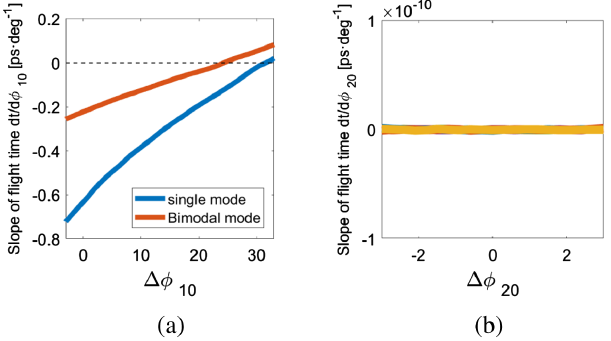
FIG. 7. Slope of flight time as function of injection phases at the gun exit. (a) The slope of ight time as function of fundamental mode injection phase dt=d ϕ 10 . △ ϕ ∘ 10 ¼ 0 represents the phase of maximum energy gain. (b) The slope of ight time as function of harmonic mode injection phase dt=d ϕ 20 . △ ϕ ∘ 20 ¼ 0 represents the phase of maximum energy gain.